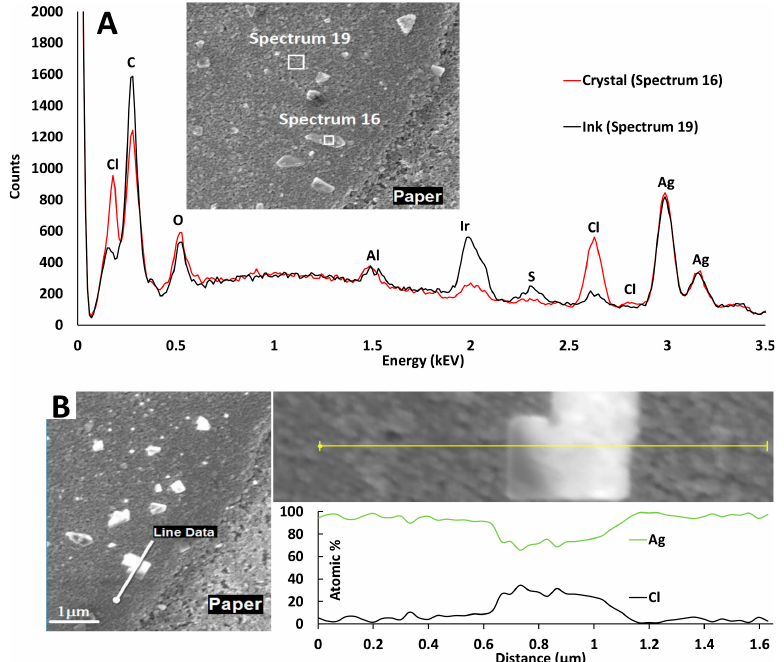
Figure 7. Verification of AgCl composition in crystals (energy dispersive spectroscopy, EDS). ( A ) Surface analysis of a crystal compared with the ink surface reference (scan areas shown as white squares). ( B ) Line analysis across a crystal. The Cl content is measured to approximately 30 atomic % across the crystal (the exact content of 50 atomic % is not reached because the electron beam is partially penetrating through the crystal so that the measurement is affected by the underlying AgNP ink layer).